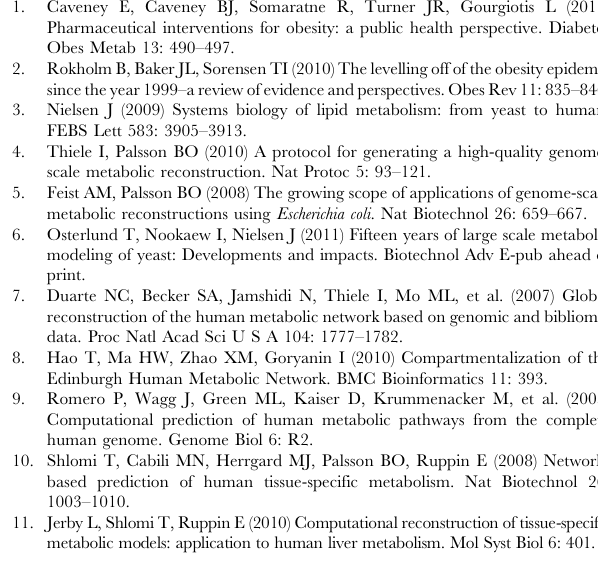
Table S10 Comparison between iHuman1512 and some other published human metabolic